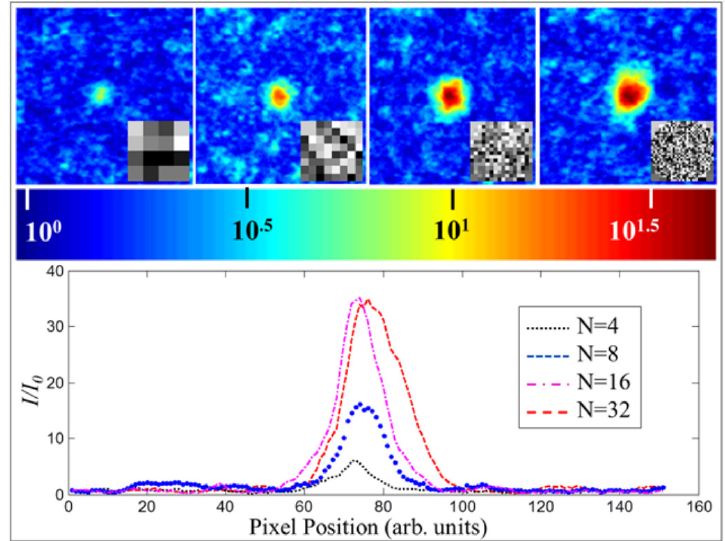
Figure 8. Optimized spot intensities for transmissive inverse diffusion for the white paint on glass sample for N = 4 through 32 (top) and corresponding intensity cross-sections (bottom). Background speckle size is relativity constant as N